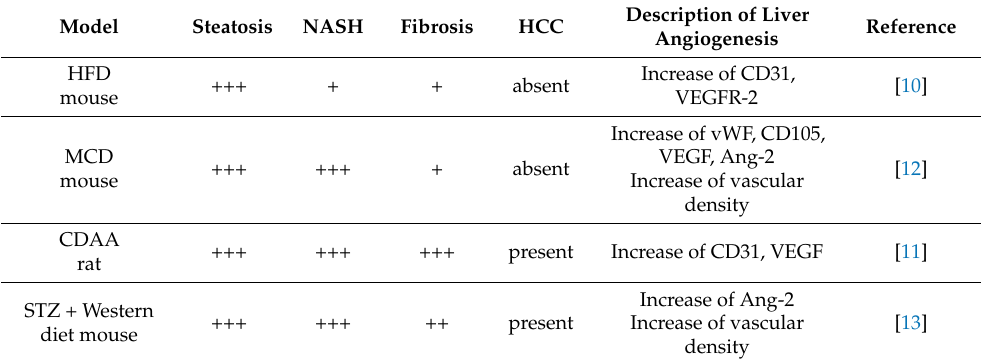
Table 1. Study of angiogenesis in animal models of non-alcoholic fatty liver disease (NAFLD).